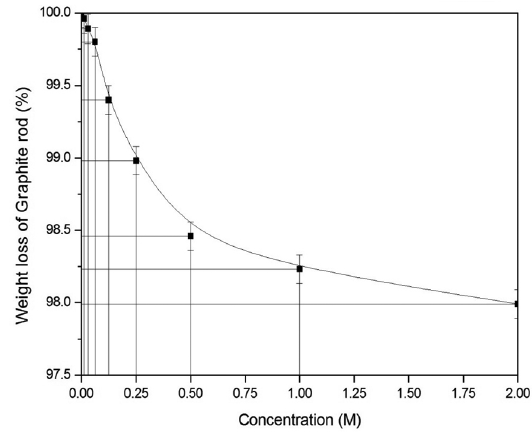
Figure 3. Effect of Weight Loss on Graphite Rod with respect to electrolyte concentration: Reaction conditions: Dimensional of graphite rod: 80 × 20mm; Temperature: 303 K; Pressure: 1 atm; Applied voltage: 12 V; Applied Current: 1.2 A; Medium: Distilled water; Reaction Time: 10 mts and Distance between the electrodes: 2 cm.